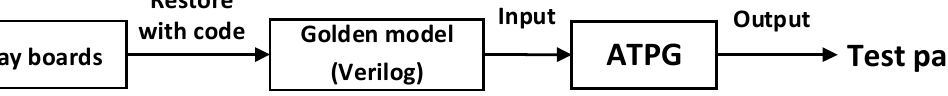
Figure 5. Algorithm test logic diagram.